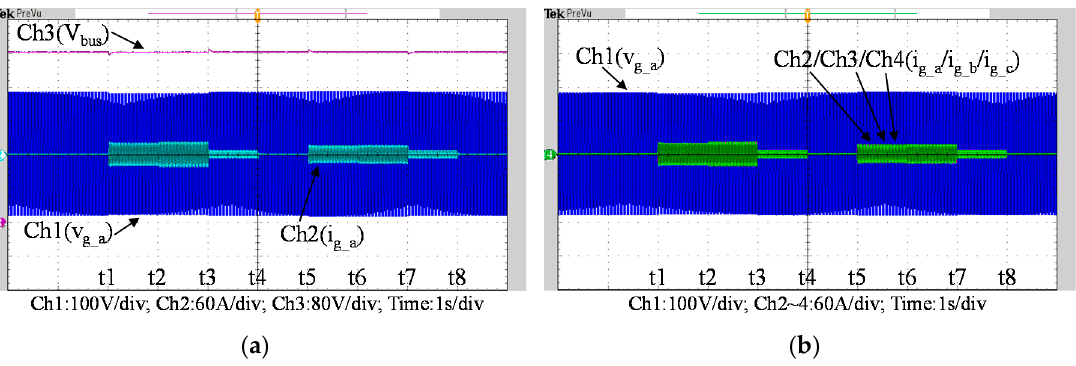
Figure 35. Waveforms of ( a ) DC bus and grid phase-a voltage and current; ( b ) three-phase currents.